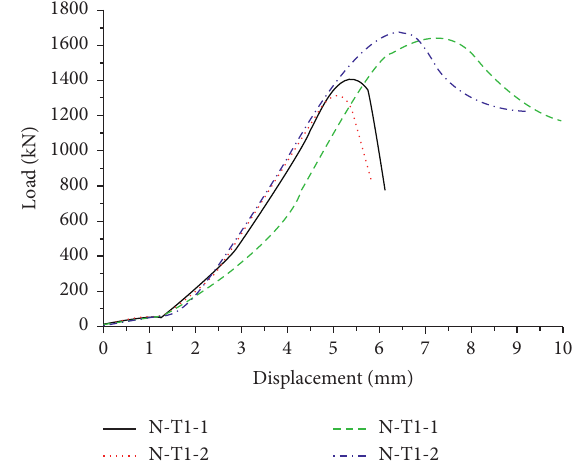
Figure 6: Load-displacement curves.